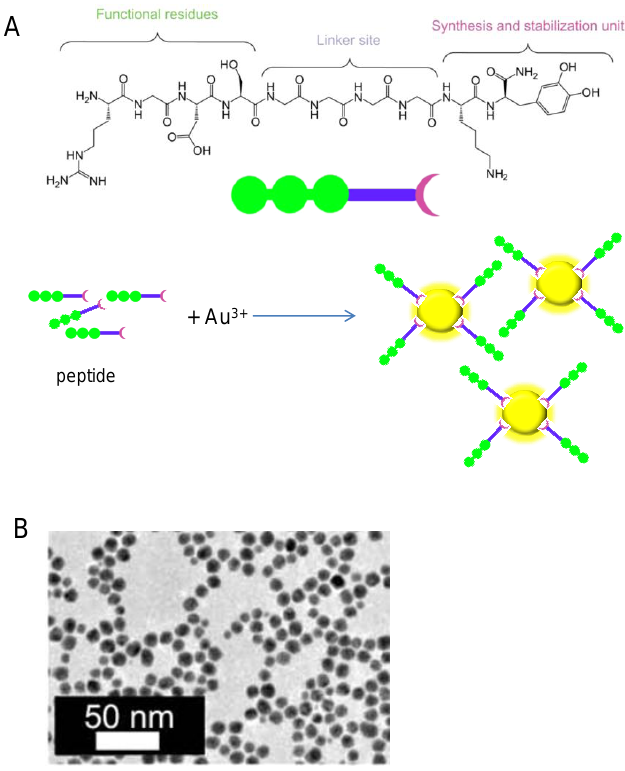
Figure 7. Synthesis of Biofunctionalized AuNPs. ( A ) Peptide and scheme of NPs formation; ( B ) TEM images of the AuNPs.